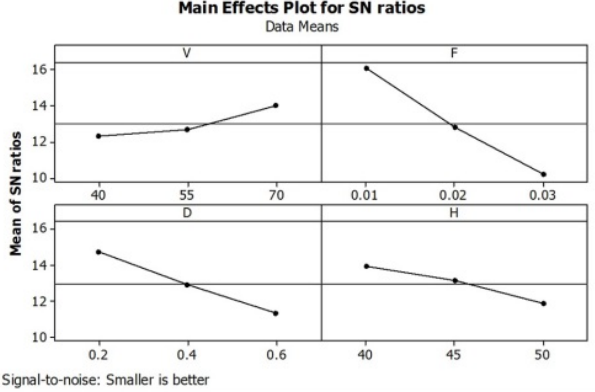
Figure 3. The effect of cutting parameters on surface roughness.